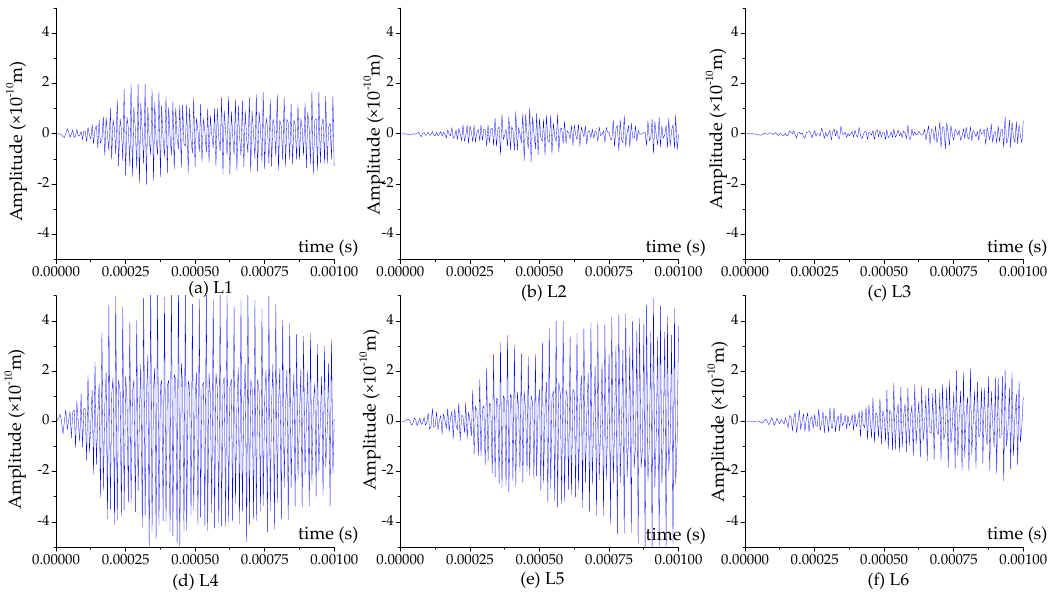
Figure 11. The displacement response at different locations at 90% grouting level.